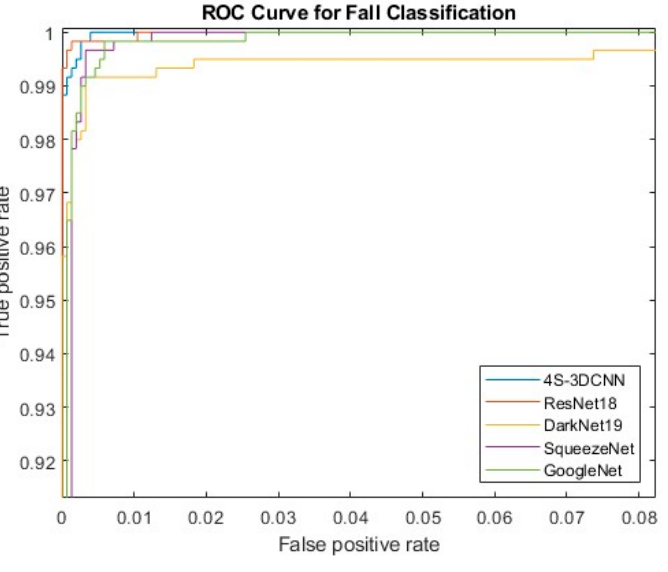
Figure 6. ROC curves for each trained model.